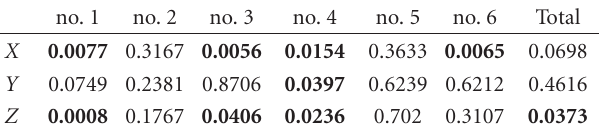
Table 7: P values of unpaired Student’s t -test on the [Test-ref] centroid location di ff erences in µ m at each component of Cast framework and titanium framework. The rightest column presents the unpaired Student’s test of in total between cast/titanium